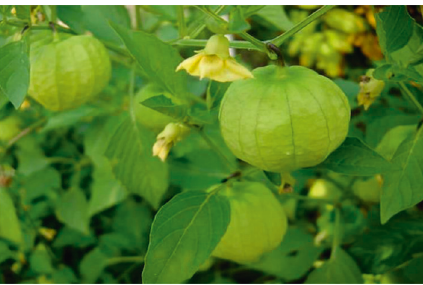
Figure 1: Physalis peruviana L. (cape gooseberry); family: